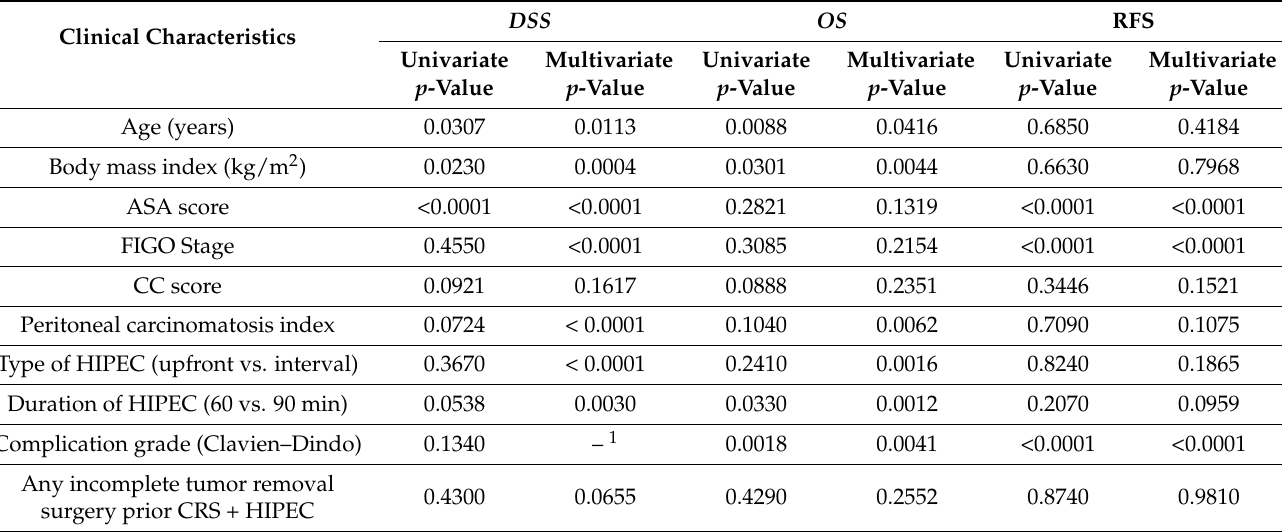
Table 2. Results of uni- and multivariate survival